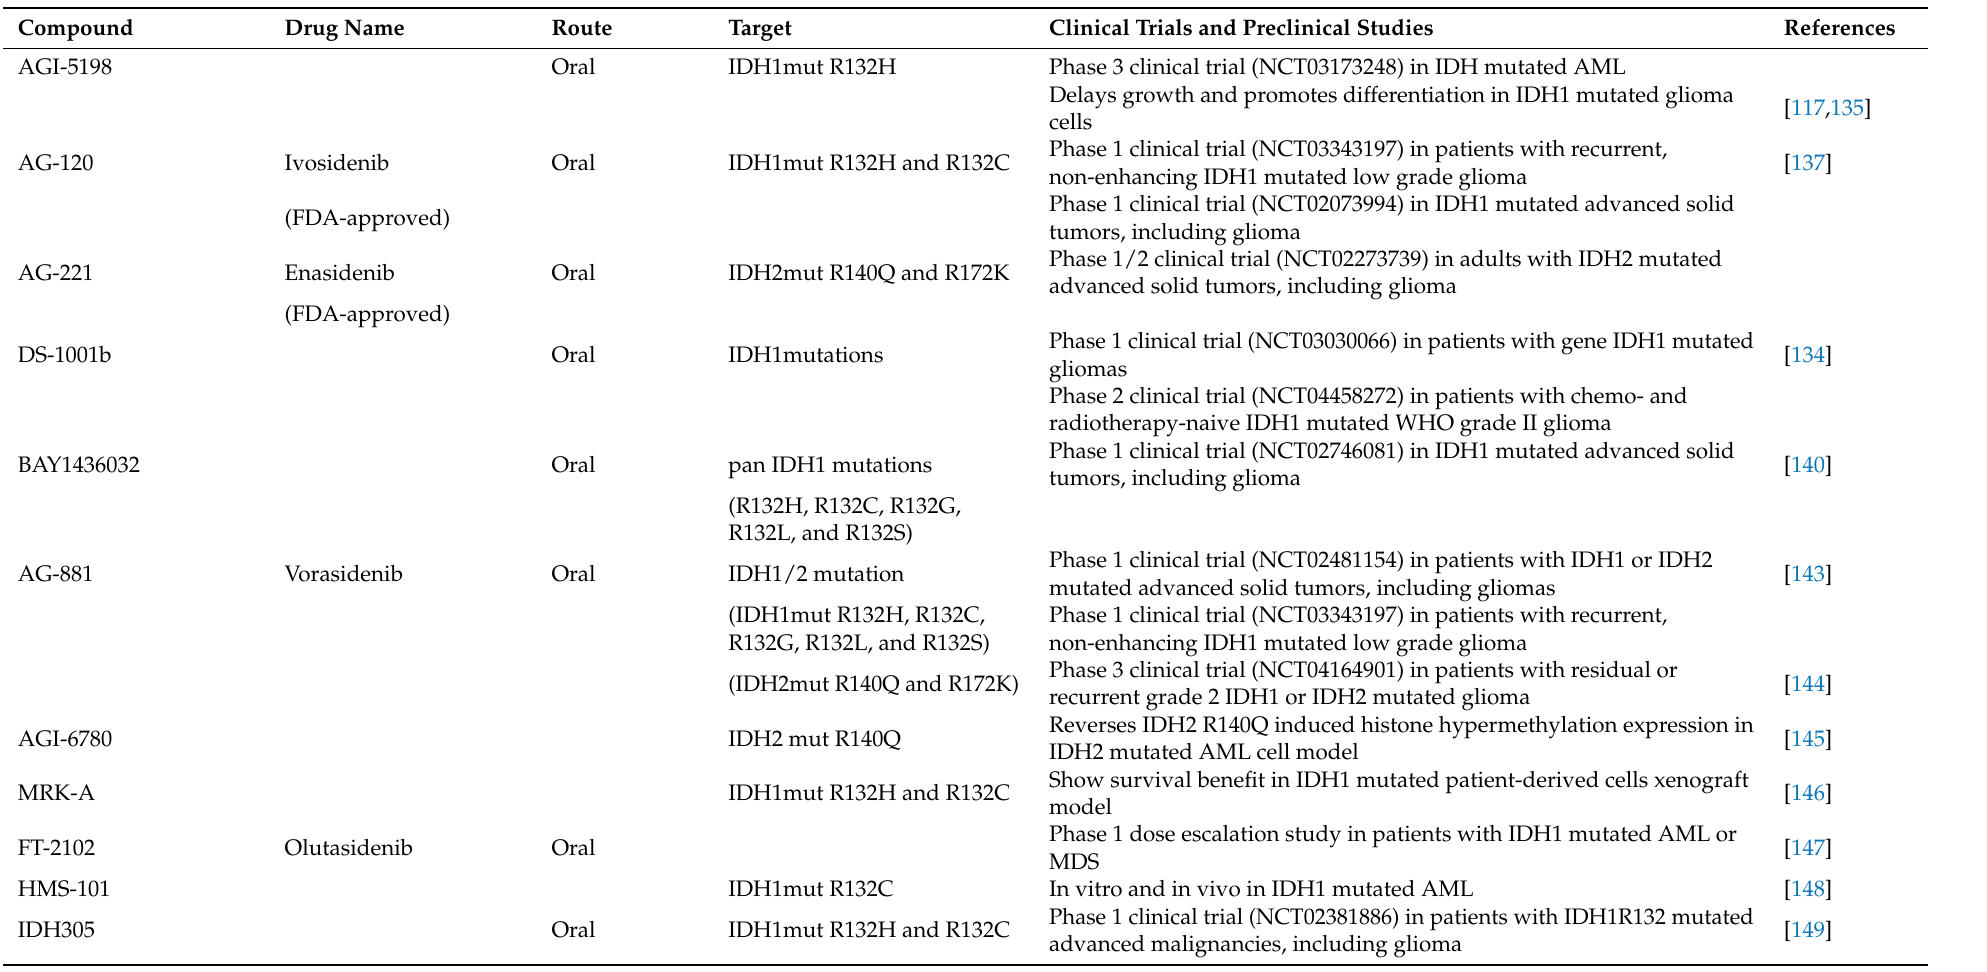
Table 2. IDH mutations inhibitors and clinical